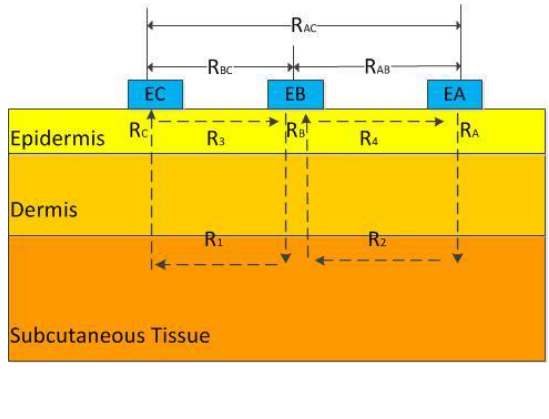
Figure 1. Three-electrode